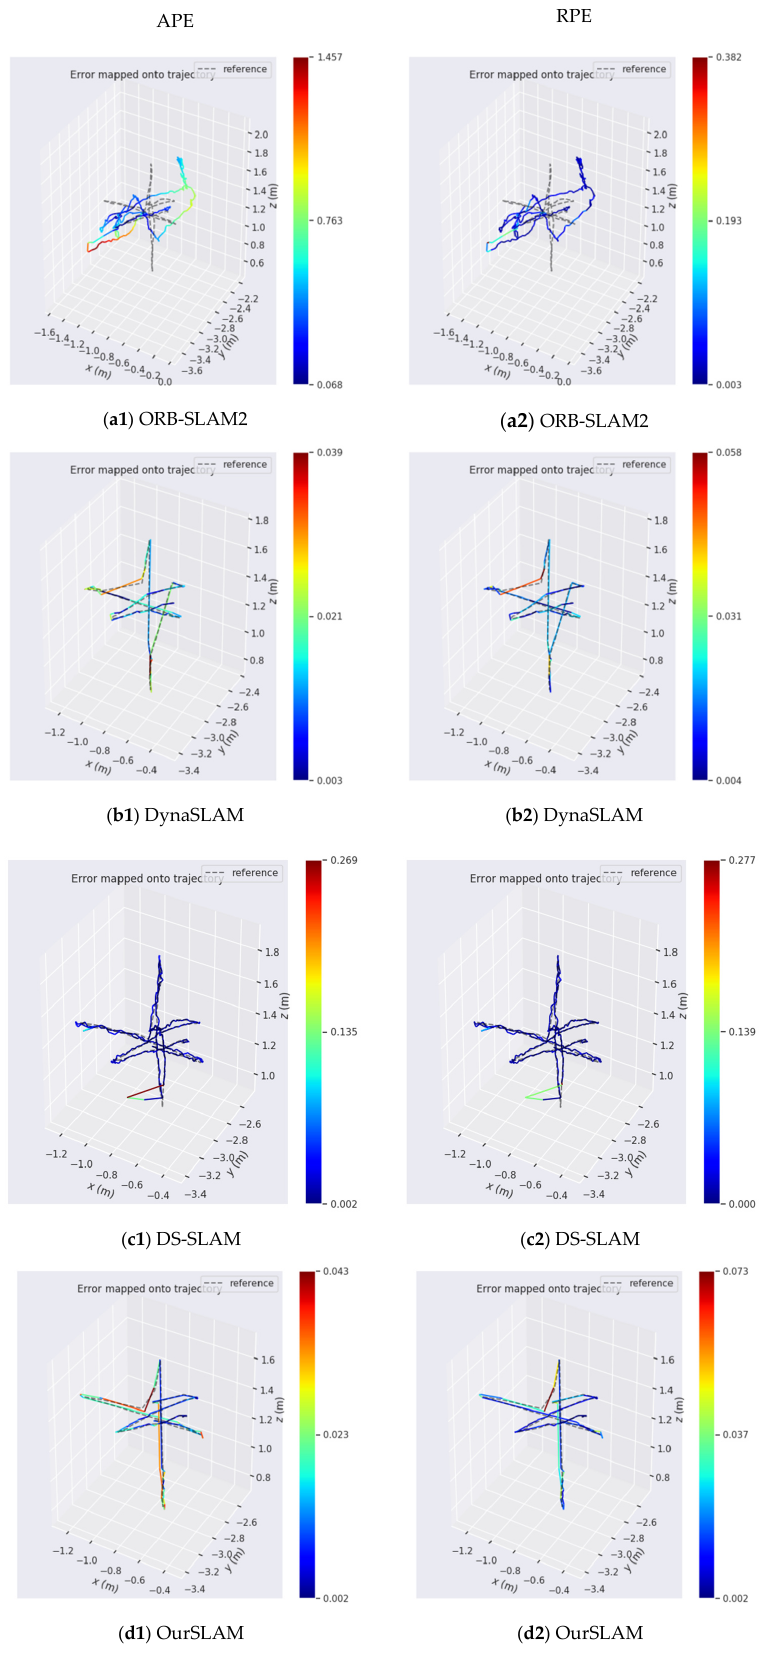
Figure 9. ORB-SLAM2, DynaSLAM, DS-SLAM, and OurSLAM absolute trajectory error mapping to trajectory map results on dataset fre3_walking_xyz. The experimental results on the fre3_walking_halfsphere dataset are as follows: As shown in Figure 10, the trajectory predictions of ORB-SLAM2, DynaSLAM, DS- SLAM, and OurSLAM on the fr3_walking_halfsphere dataset are compared. This paper uses lines of different colors to represent the trajectory images of four different algorithms: ORB-SLAM2, DynaSLAM, DS-SLAM, and OurSLAM. As shown in Figure 10a, the dotted line represents the real trajectory; the blue line represents the track of the ORB-SLAM2 algorithm; the green line represents the track of the DynaSLAM algorithm; the red line represents the track of the DS-SLAM algorithm; and the purple line represents the trajec- tory of the OurSLAM algorithm. As can be seen from Figure 10a, the matching accuracy between the real trajectory and the trajectory of the ORB-SLAM2 algorithm in the dynamic environment is almost zero. Although the matching between the real trajectory and the trajectory of the DynaSlam algorithm and the DS-SLAM algorithm is greatly improved compared with the ORB-SLAM2 algorithm, there are still some shortcomings compared with the algorithm in this paper. It is obvious from Figure 10b that the trajectory of the ORB-SLAM2 algorithm differs too much from the real trajectory on each coordinate axis of x , y , and z . The accuracy of the matching result is very low. The matching results of the trajectories of DynaSLAM and DS-SLAM are roughly the same as those of the real trajec- tories on each coordinate axis of x , y , and z , and have a certain accuracy, but there is still a certain error in the peak and valley of the image. The matching results of the OurSLAM trajectory on the x , y , and z , axes are consistent with the real trajectory, and have a good